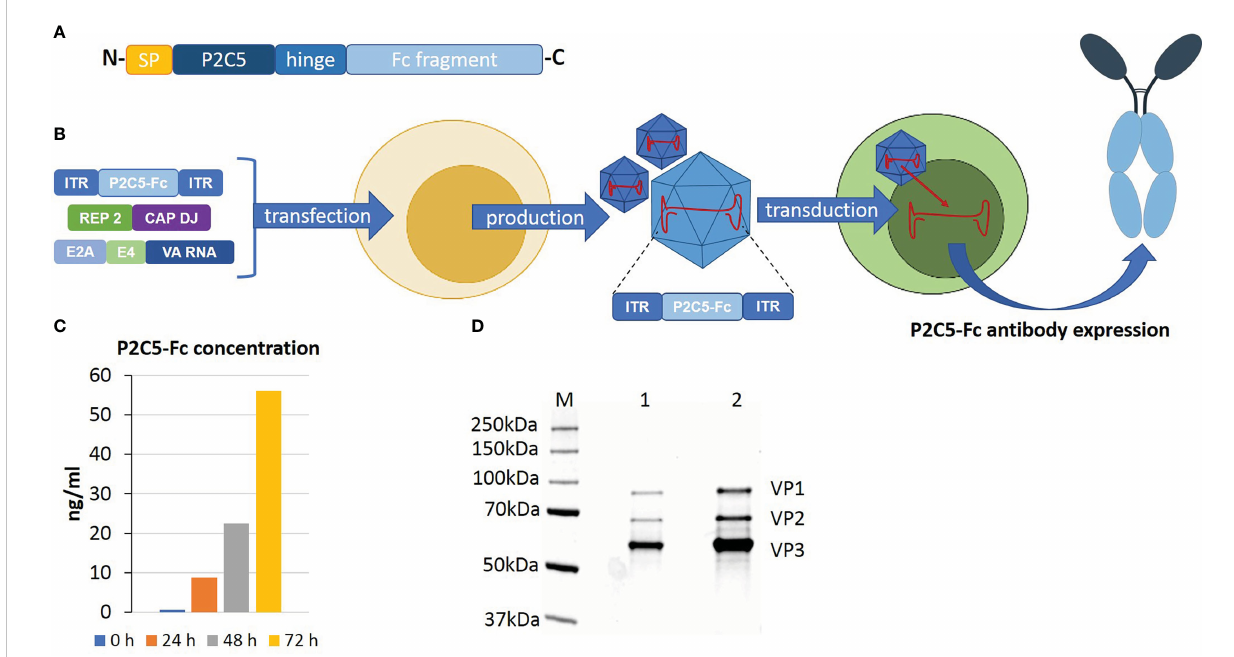
FIGURE 1 An overview of rAAV-P2C5-Fc preparation and analysis. (A) Structure of recombinant P2C5-Fc antibody: SP – amino acid sequence of signal peptide of IgG1 heavy chain; P2C5 – amino acid sequence of P2C5 single domain antibody; hinge – amino acid sequence of hinge region of IgG1; Fc fragment amino acid sequence Fc fragment of IgG1. (B) Schematics of rAAV-P2C5-Fc production and mechanism of action. (C) Evaluation of rAAV- P2C5-Fc transducing activity using HEK293 cells: bars indicate concentration of P2C5-Fc antibody in cultural media, cultivation time is shown by color. (D) SDS-PAGE of an rAAV-P2C5-Fc purity and authenticity analysis: M – protein molecular weight marker; 1, 2 fractions of puri fi ed rAAV- P2C5-Fc; VP1, VP2, VP3 rAAV capsid